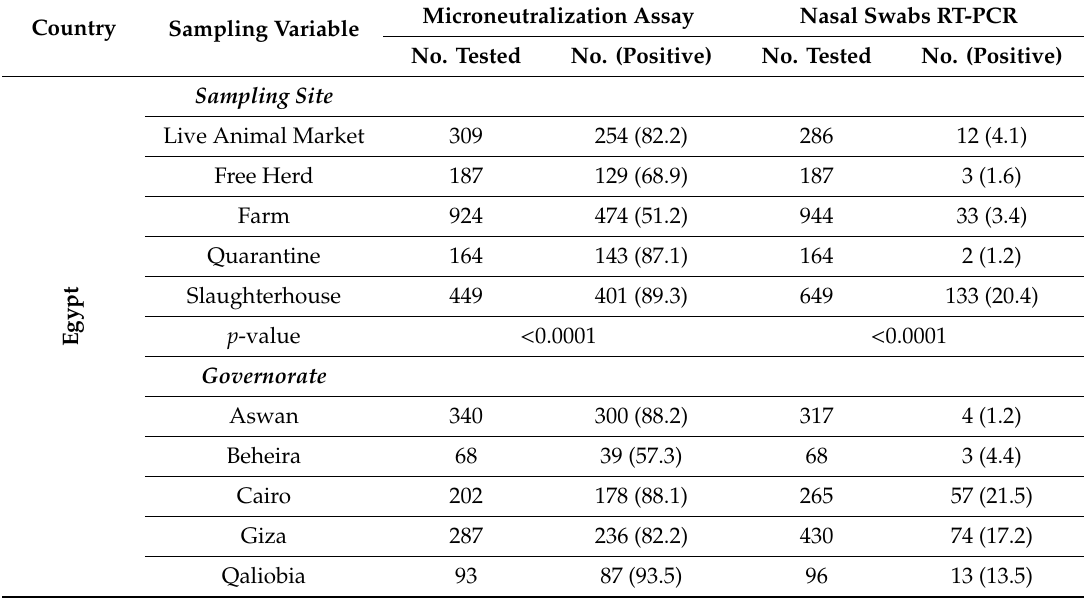
Table 1. MERS-CoV microneutralization and nasal swab RT-PCR test results by sampling site, age, sex and animal